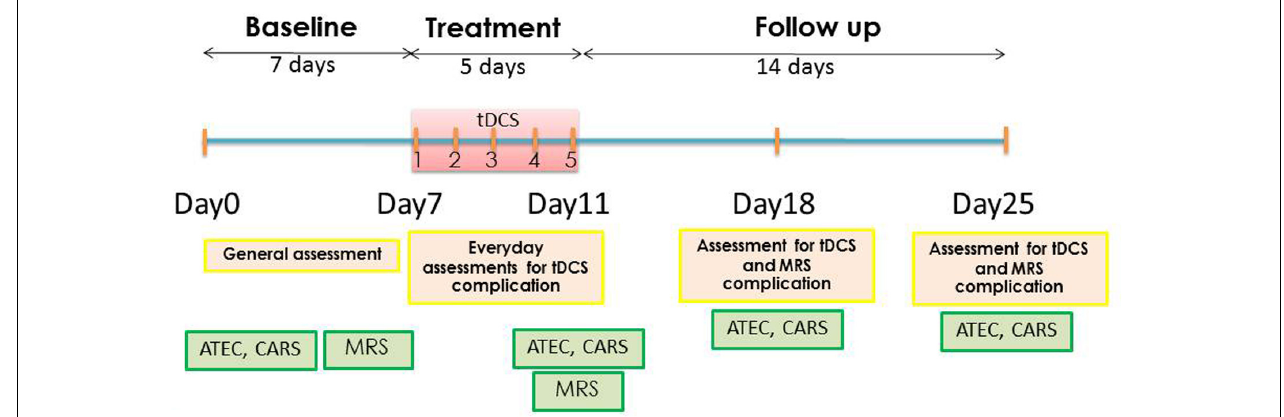
FIGURE 1 | Schematic representation of experimental